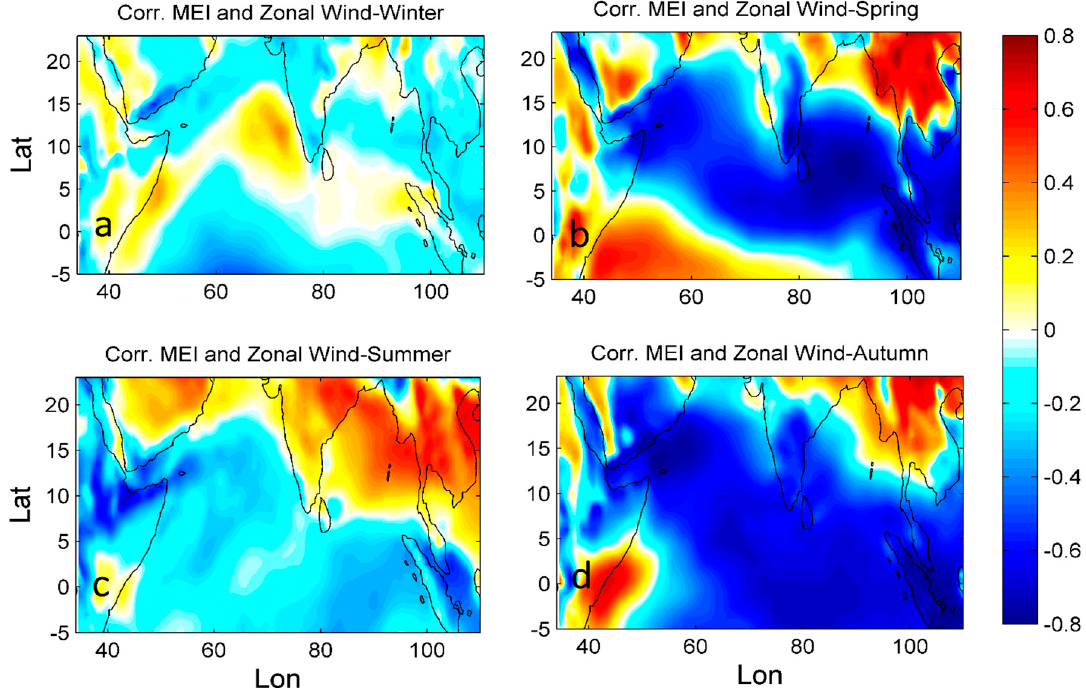
Figure 8. The spatial correlation pattern of multivariate El Niño index (MEI) and zonal wind in the Indian Ocean (IO) ( a – d ) during winter, spring, summer, and autumn, respectively. Zero lines are omitted.